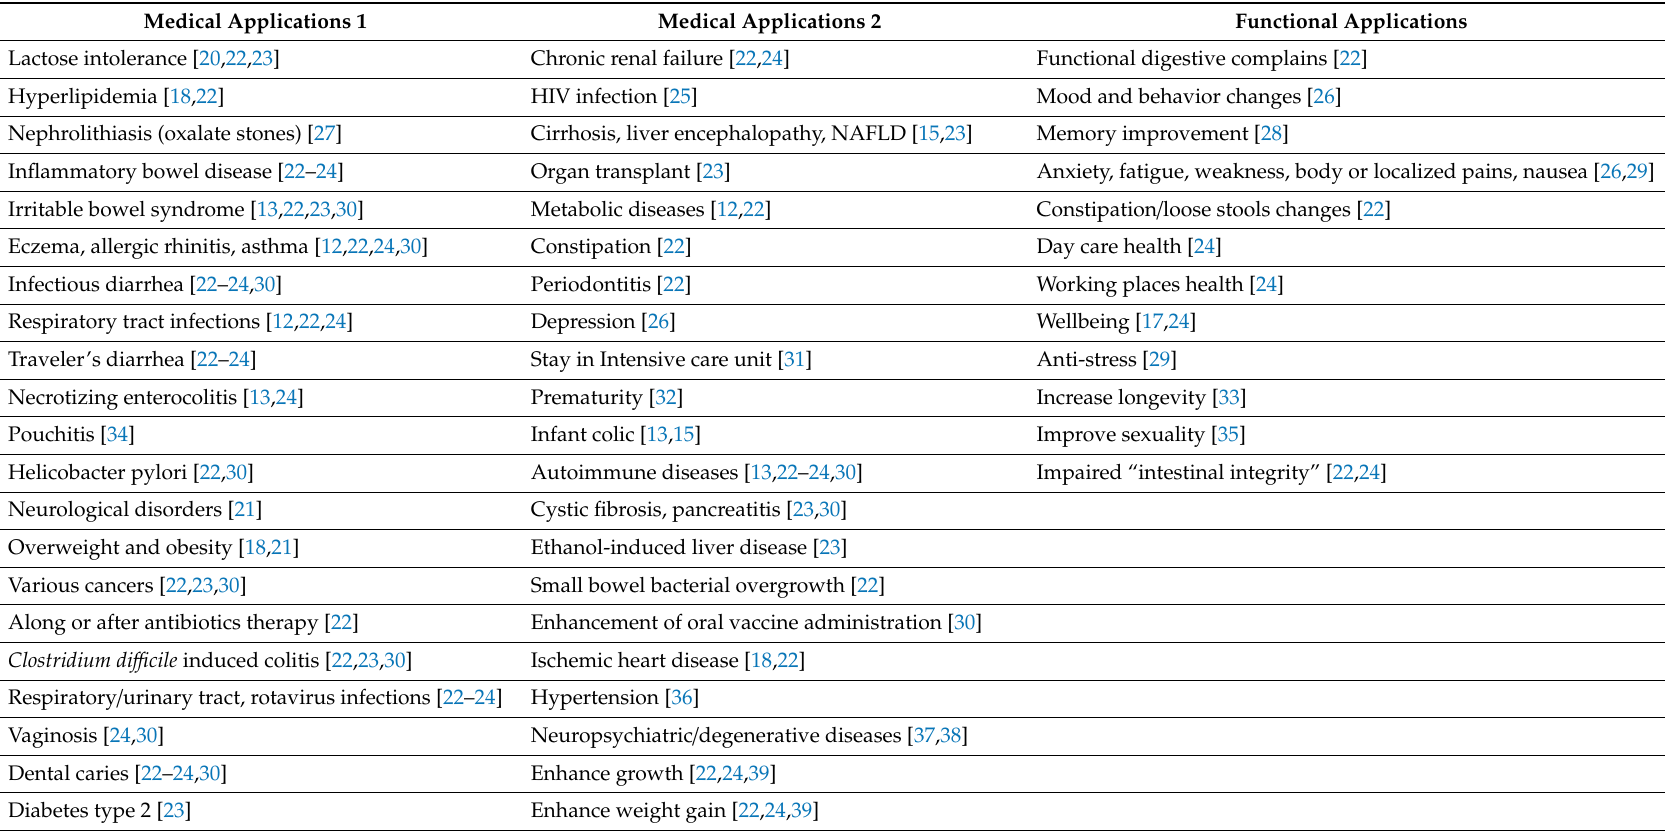
Table 1. Medical and non-medical indications for probiotic